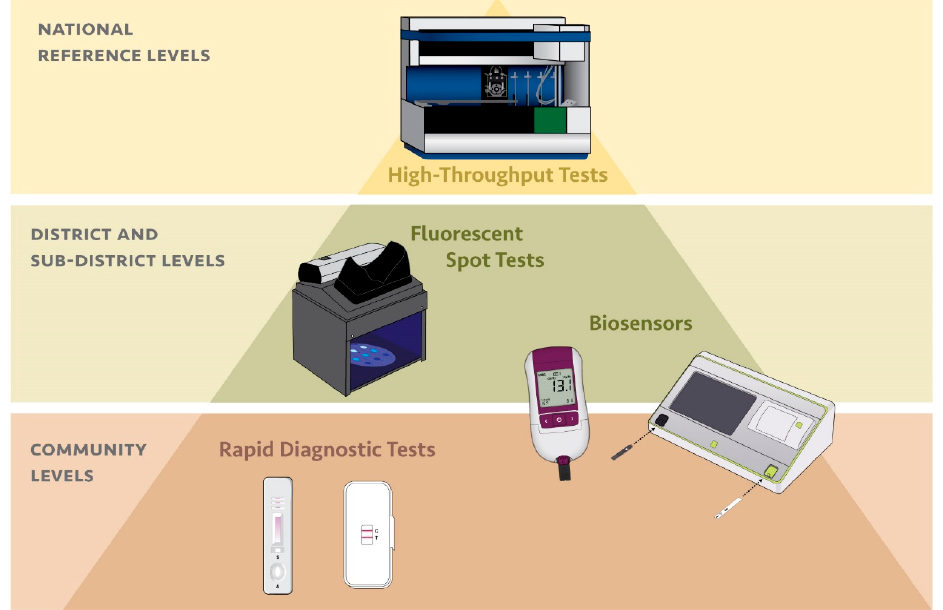
Figure 1. Alignment between diagnostic platform for G6PD deficiency and tier of health care facility based on complexity of the diagnostic test and the typical resources available at each type of facility. Table 2. Characteristics of qualitative and quantitative point-of-care G6PD tests.